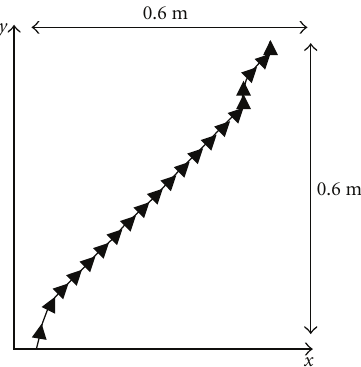
Figure 10: Trajectory for a diagonal desired position.